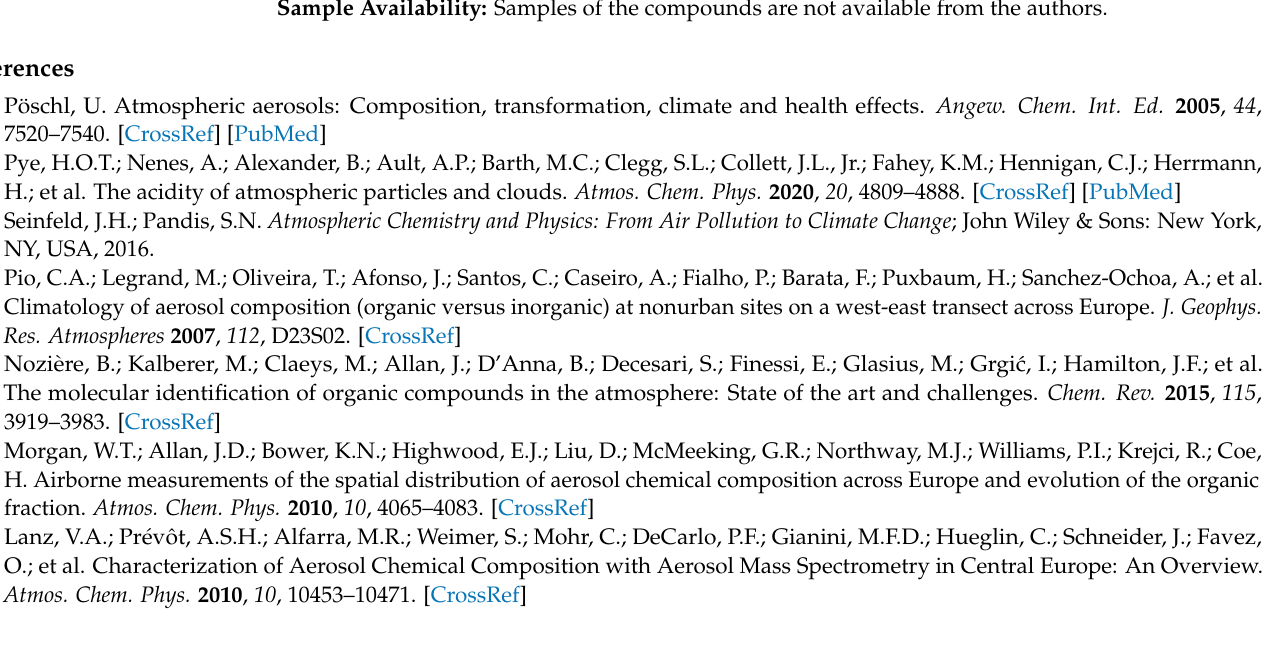
DataAnalysis; Table S1: Microphysical and physico-chemical characterization of the cloud water sample; Table S2: List of internal recalibrants; Table S3: Parameters used for formula assignment; Table S4: High intensity MF in MFAssignR SPE2_SPE3. The column “Error (ppm)” reports the error associated to the formula assignment; “Composer” reports the fraction where the MF is present in Composer data treatment, with the associated error, and “DataAnalysis” the fraction in DataAnalysis data treatment, with the associated